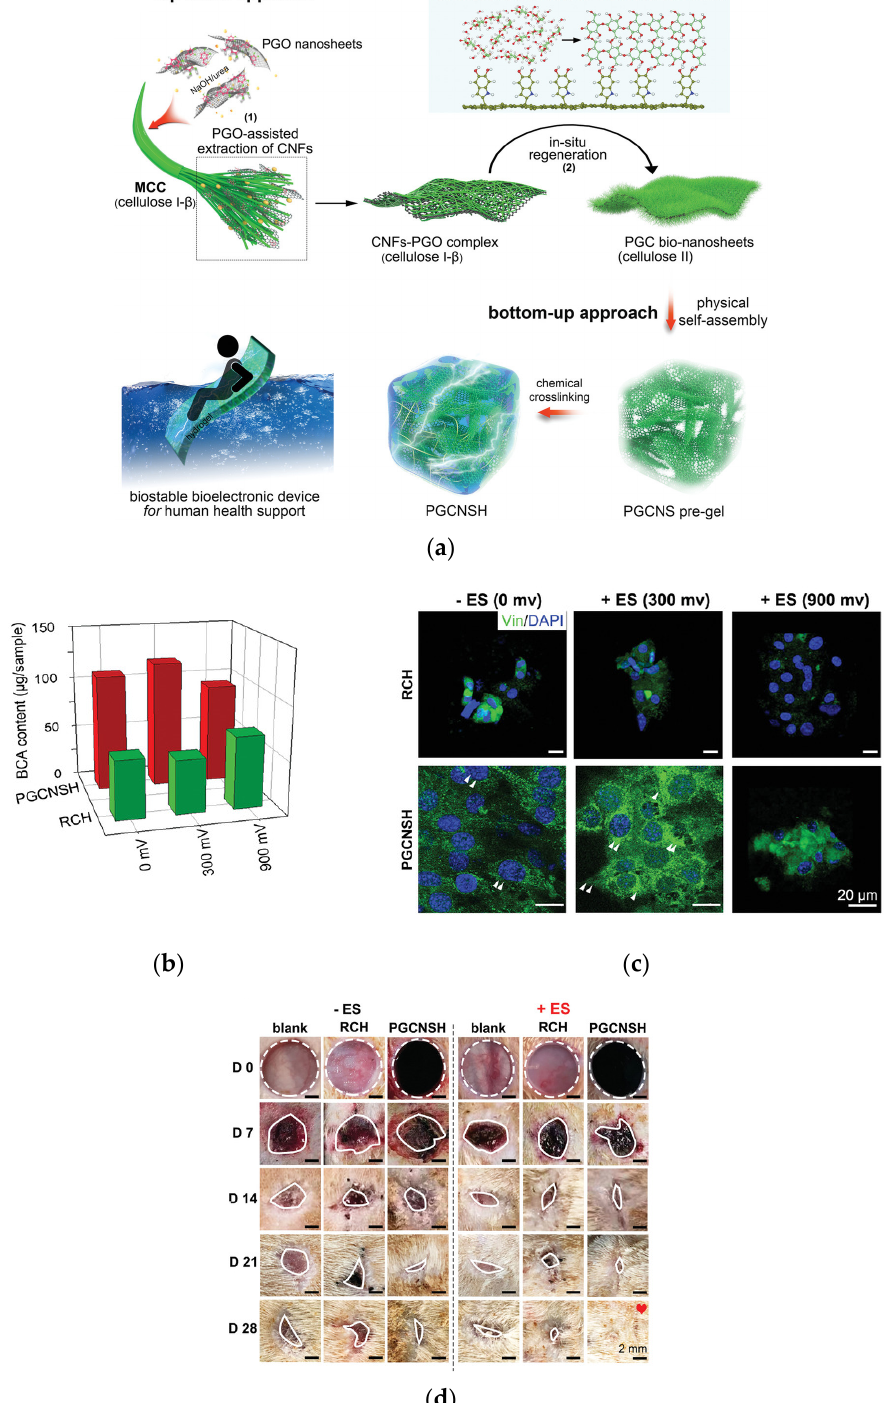
Figure 7. Cellulose-based hydrogels for wound healing. ( a ) Design strategy for 2D conductive cellulose nanosheets and their assembly into biostable and conductive 3D bulk hydrogels. ( b ) BCA content of C2C12 cells on the hydrogels after three days of culturing. ( c ) Immunofluorescent staining for focal adhesion formation of C2C12 cells on day three. Vinculin, a focal adhesion protein, was stained with green, and cell nuclei were counterstained with blue. ( d ) Images of hydrogel-treated wounds with and without electrotherapy. Adapted with permission from Ref. [5], Copyright 2021, Wiley-VCH GmbH.